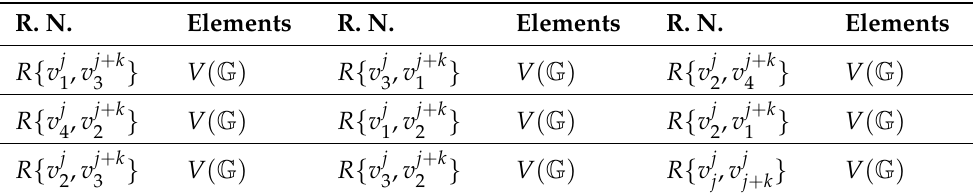
Table 21. RNs ´ R u for 106 ≤ u ≤ 141, 1 ≤ j ≤ 8, k = 1,3,5. R.